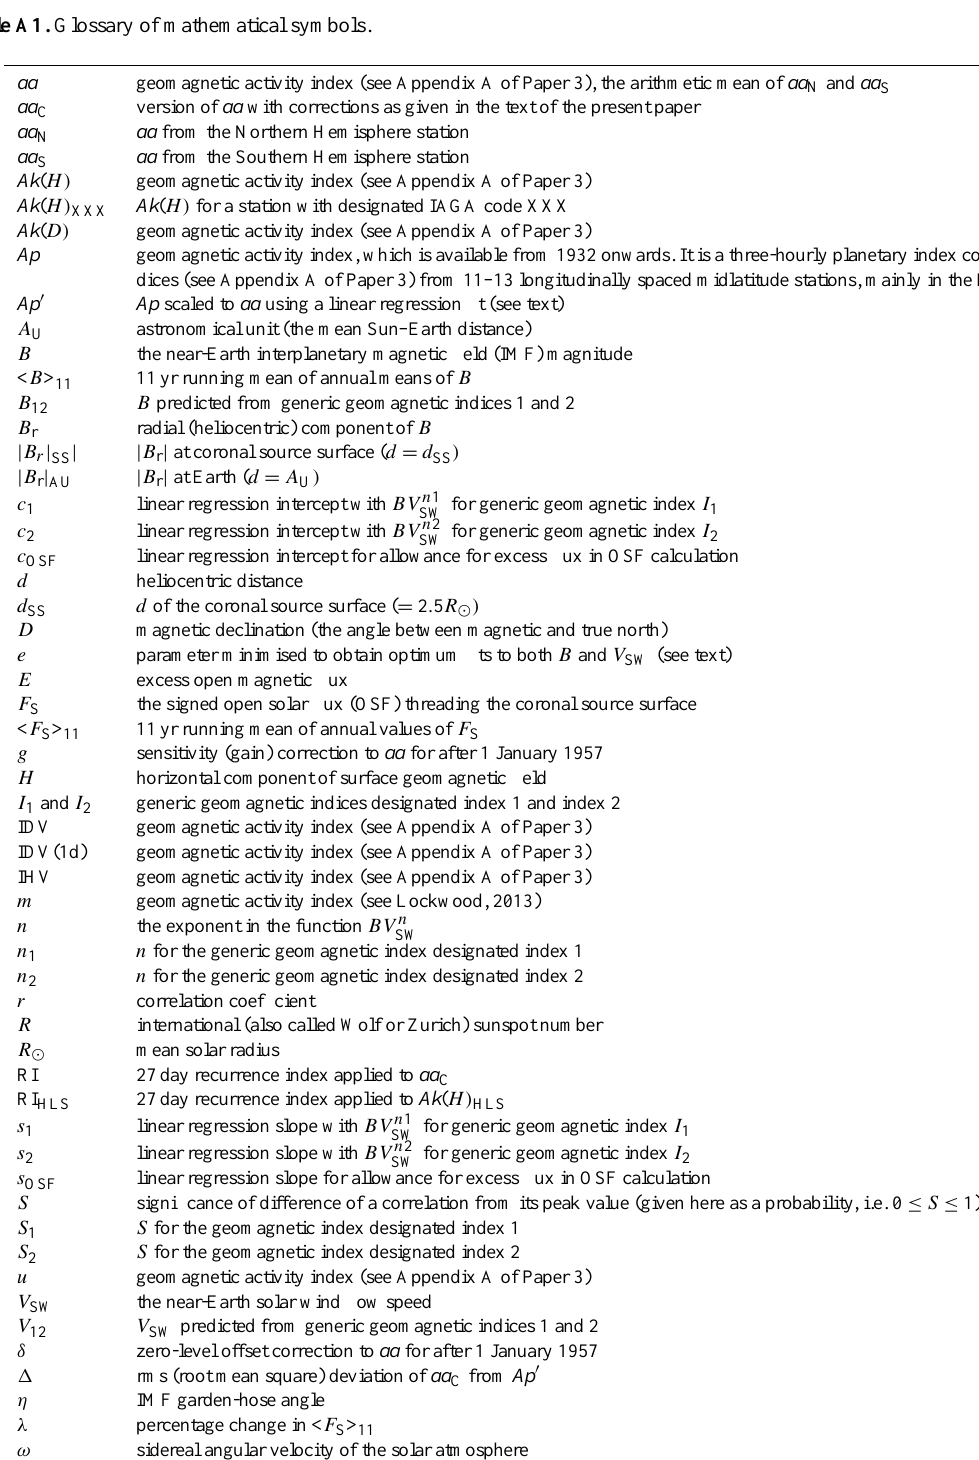
Table A1. Glossary of mathematical